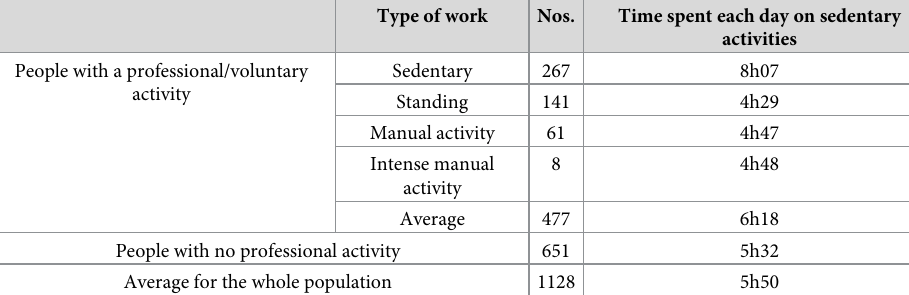
Table 7. Time spent each day on sedentary activities broken down by type of work (for people in a professional/ voluntary activity, n = 477, i.e. 39.5% of the respondents). Type of